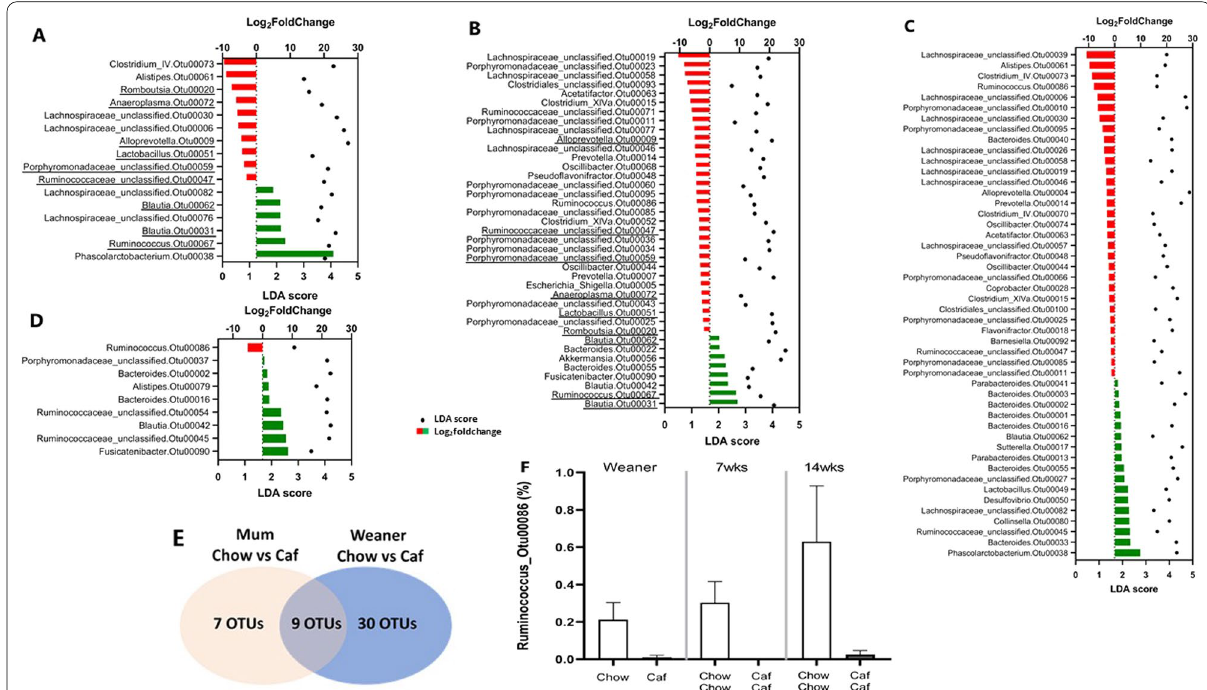
Fig. 5 OTUs significantly altered between groups. Microbial taxa among the top 100 OTUs identified to significantly differ in abundance between A mothers (Chow vs. Caf); B weanlings (Chow vs Caf), underlined OTUs indicate 9 common taxa between mothers and weanlings; C offspring at 7 weeks (ChowChow vs CafCaf); and D offspring at 14 weeks (ChowChow vs. CafCaf) by DESeq2 ( padj < 0.05) and LEfSe (LDA Score > 2.0, p < 0.05). In DESeq2, negative (red) Log2foldchange value denotes decreased abundance and positive (green) Log 2 foldchange value denotes increased abundance in A Caf mother; B Caf weaner; C 7 week offspring in CafCaf group; and D 14 week offspring in CafCaf group. E Differential OTUs 7 OTUs and 30 OTUs were uniquely altered in Mothers and Weanlings by maternal Caf diet, with 9 common OTUs in Caf Mothers and Caf Weanlings. F Relative abundance of Ruminococcus _Otu00086 in 3-, 7- and 14-week offspring fed Caf diet compared with offspring fed chow diet. Note differences were significant using both LEfSe and DESeq2